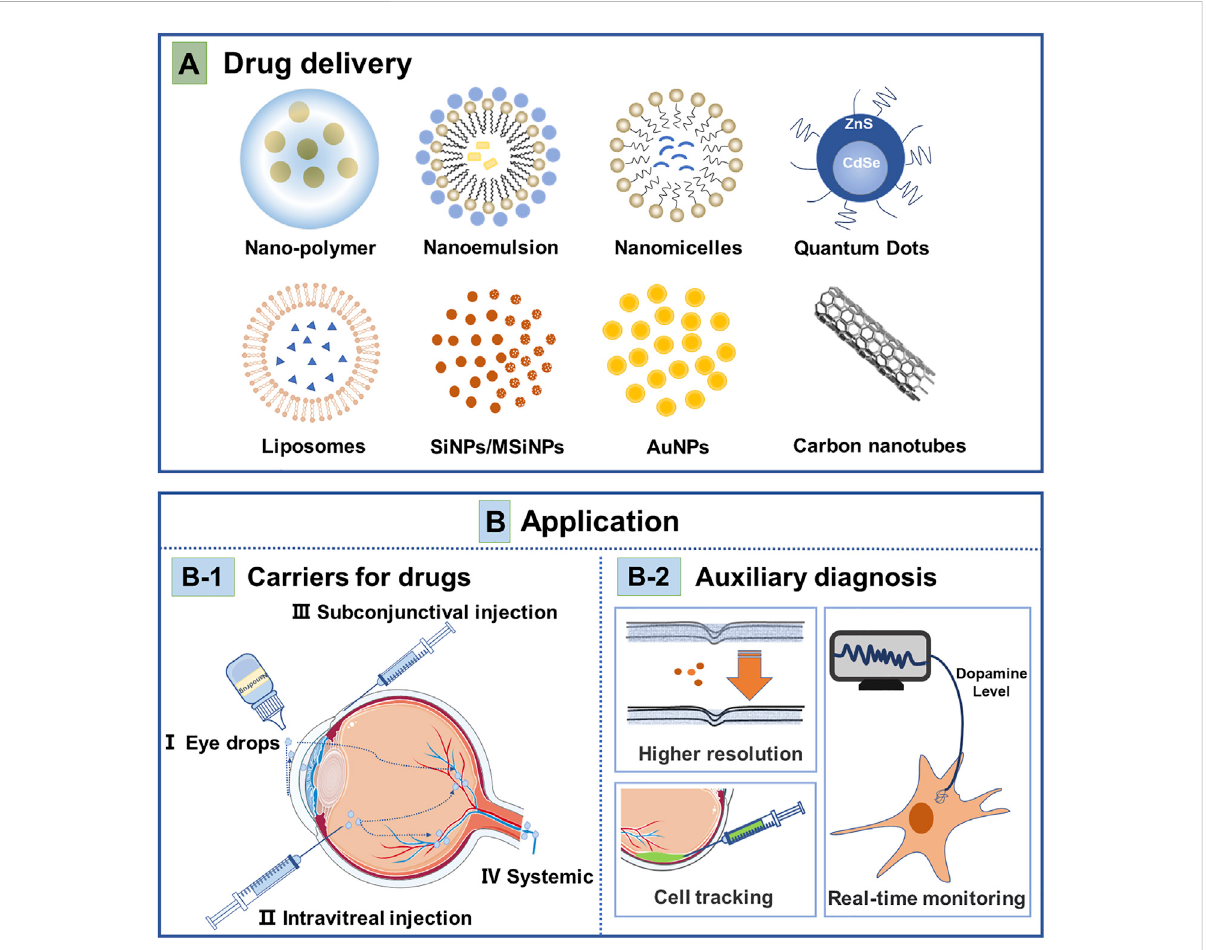
FIGURE 1 Nanotechnology-based strategies for treatment and diagnosis of ocular disease. (A) Drug delivery; The main nanoparticles currently being investigated for drug delivery in ophthalmology are nano-polymer, liposomes, nanoemulsion, nanomicelles, quantum dots, (mesoporous) silica nanoparticles (SiNPs/MSiNPs), gold nanoparticles (AuNPs) and carbon nanotubes. (B) Nanoparticles application in ocular diseases. B-1 Carriers for drugs: There are currently three routes of drug delivery by nanocarriers, mainly eye drops, intravitreal injection, subconjunctival injection, and systemic administration. B-2 Auxiliary diagnosis includes nanoparticles as a contrast agent to enhance the resolution of ophthalmic OCT and PAM examinations,nanoparticlesfusedtocellscantracertransplantedcellsincelltransplantationtherapy,andnanoparticles allowreal-timedetectionof intracellular dopamine